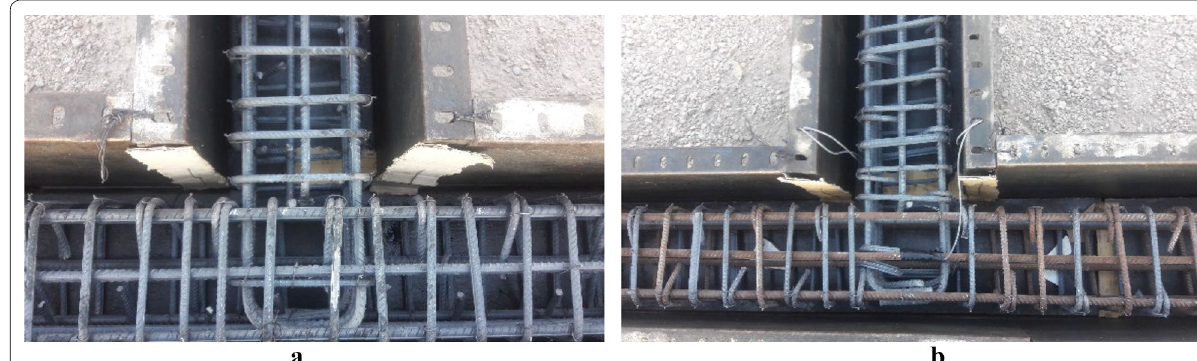
Fig. 9 Construction details of specimens: a Specimen J 1 ; b Specimen J 2 .